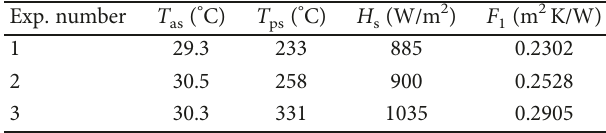
Table 2: Calculation of the fi rst fi gure of merit for the dual parabolic re fl ector solar cooker during experiment numbers 1, 2, and